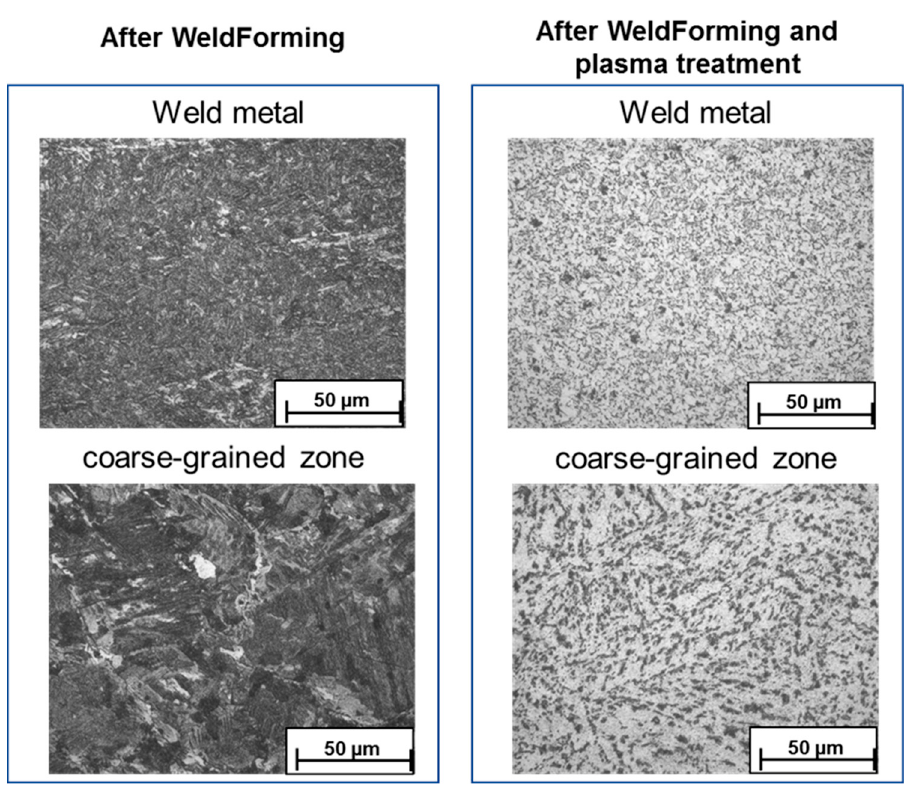
Figure 25. Micrographs of the weld metal and the coarse-grained zone after WeldForming and after WeldForming with plasma post-treatment.